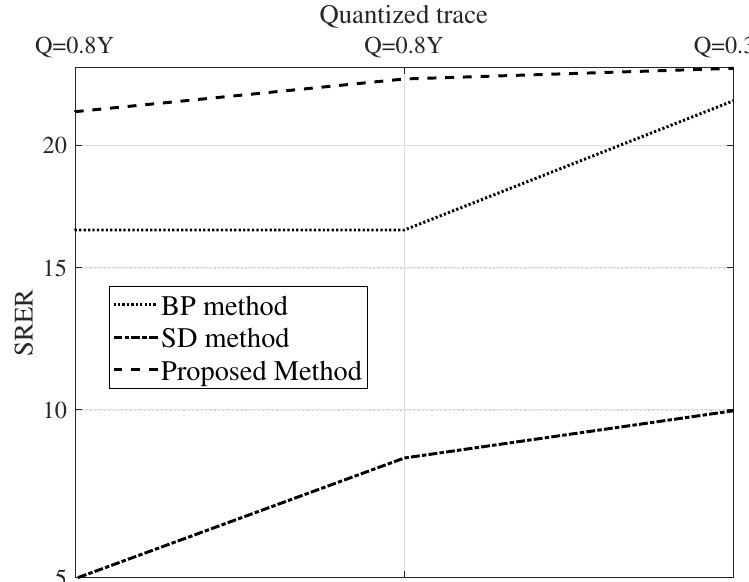
Figure 8. Normalized correlation coefficient ( γ ) versus SNR with 20 traces.